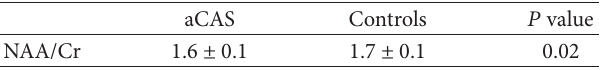
Table 3: Significant NAA/Cr difference in the left hippocampus between two